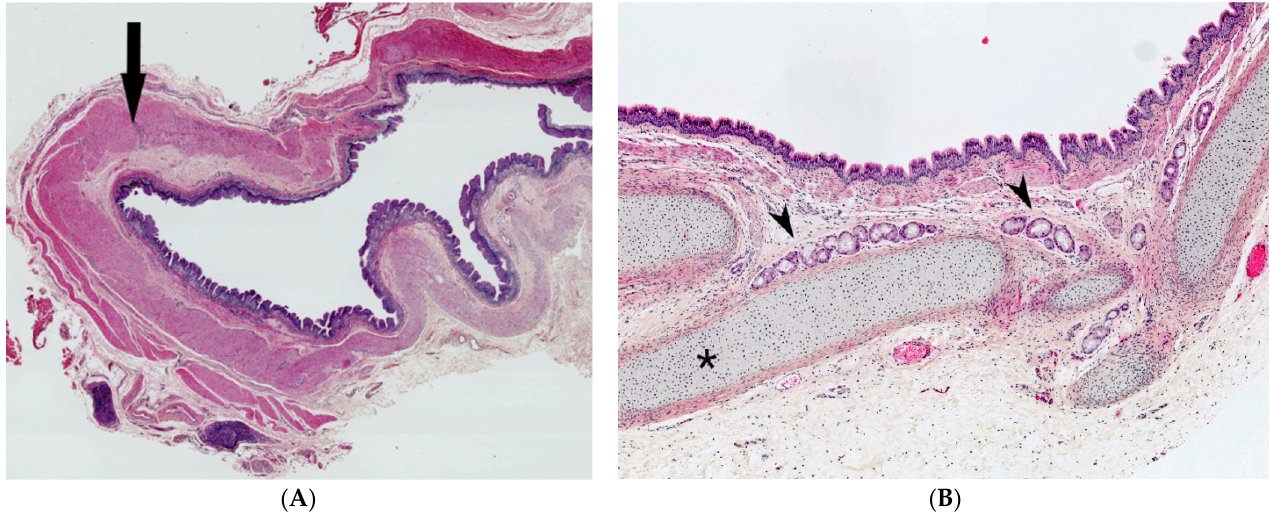
Figure 7. Bronchogenic cyst. ( A ), (H.E.S). unilocular cyst lined by respiratory epithelium overlying circular muscular tunic (arrow). ( B ), (H.E.S.). In the wall, seromucous glands (arrowheads) and cartilage plates (*).